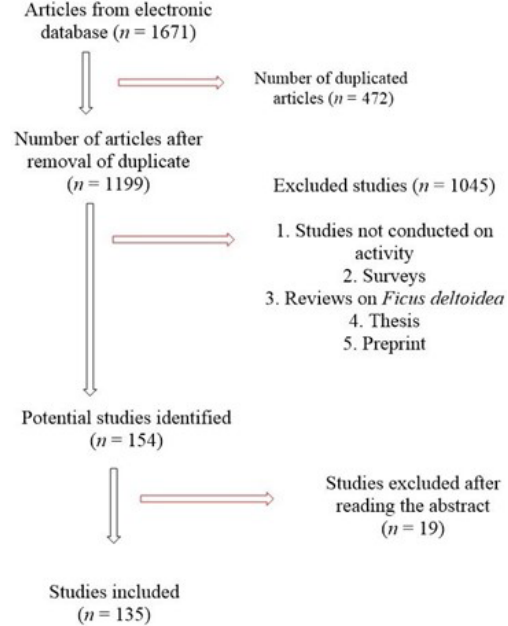
Figure 1. Methodological flow diagram showing inclusion and exclusion